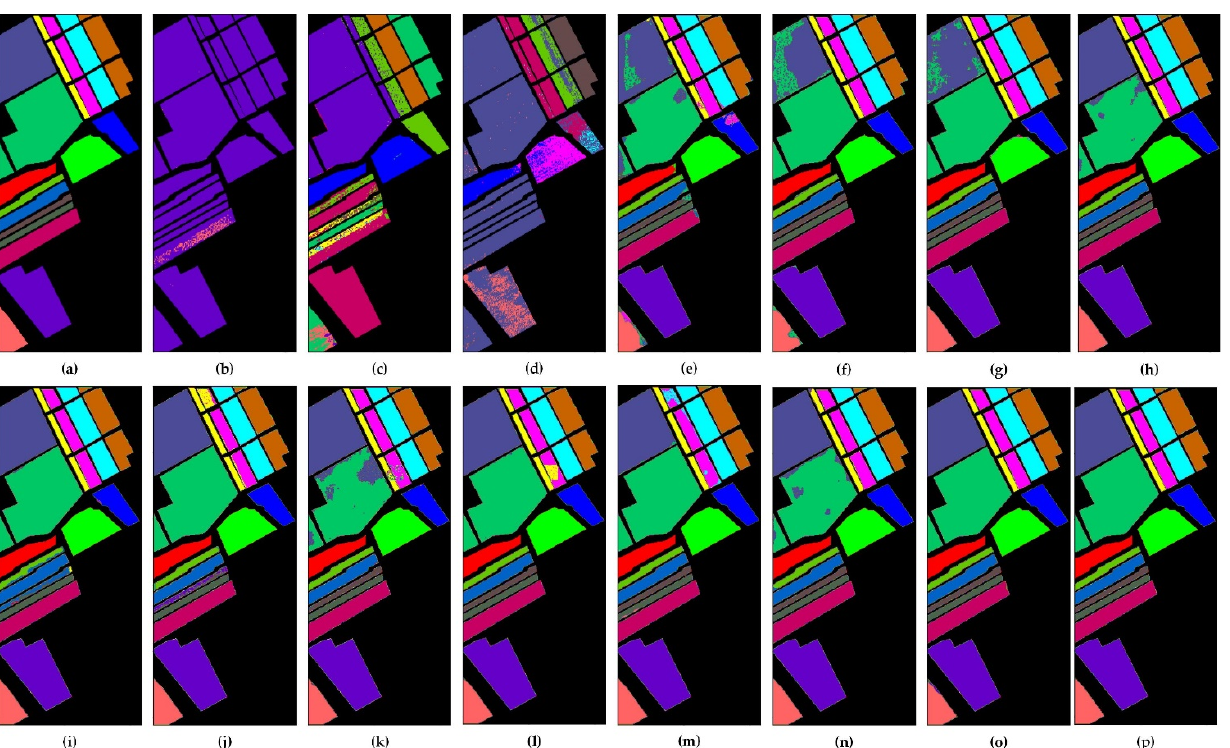
Figure 18. Classification maps on the SA dataset. ( a ) Ground truth. ( b ) SVM. ( c ) RF. ( d ) MLR. ( e )